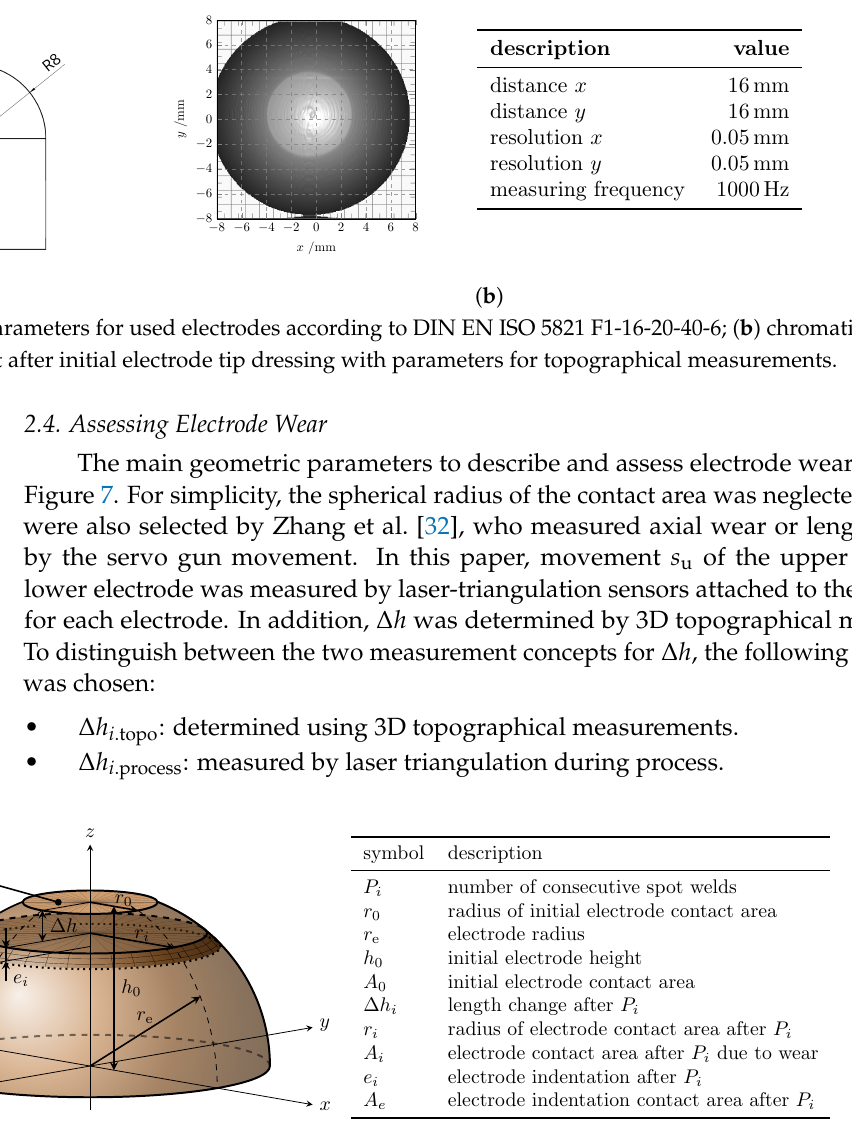
Figure 7. Geometric parameters of electrode